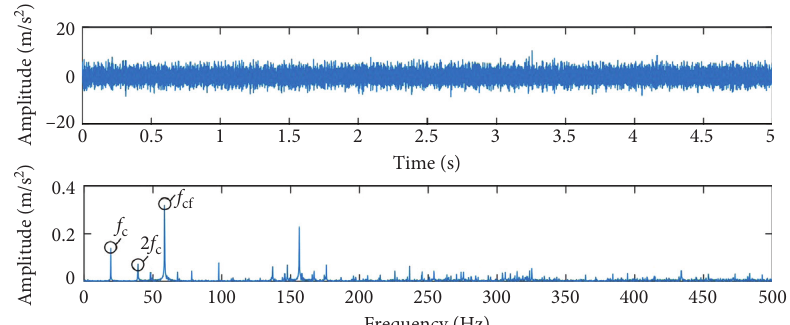
Figure 23: Original vibration signal.